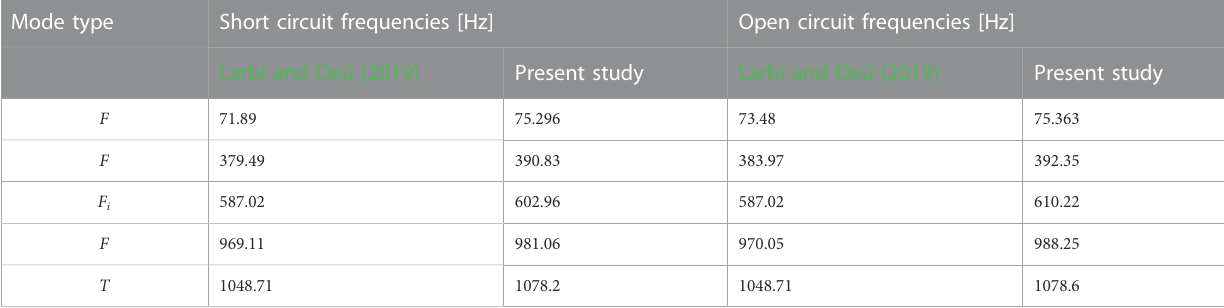
TABLE 2 Veri fi cation of numerical simulation for a cantilever with open/short shunt circuit. Mode type